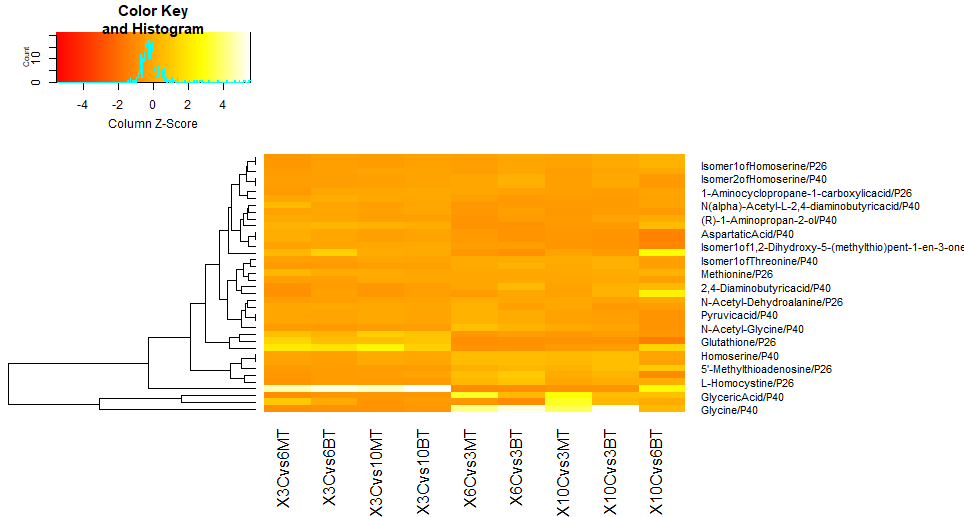
Figure 4. Heat map showing some of the differentially expressed metabolites of dipeptides and tripeptides pathway (P31) in different comparisons between positive control plants (C) and Metarhi- zium (MT) or Beauveria (BT) treatments at different Dpi. Z score is a measure of distance, in standard deviations, from the plate mean. A well with a Z score of 0 has the same raw value as the plate mean. A well with a Z score of 1.0 is exactly one standard deviation above the plate mean and a Z score of −0.5 is half a standard deviation below the plate mean.